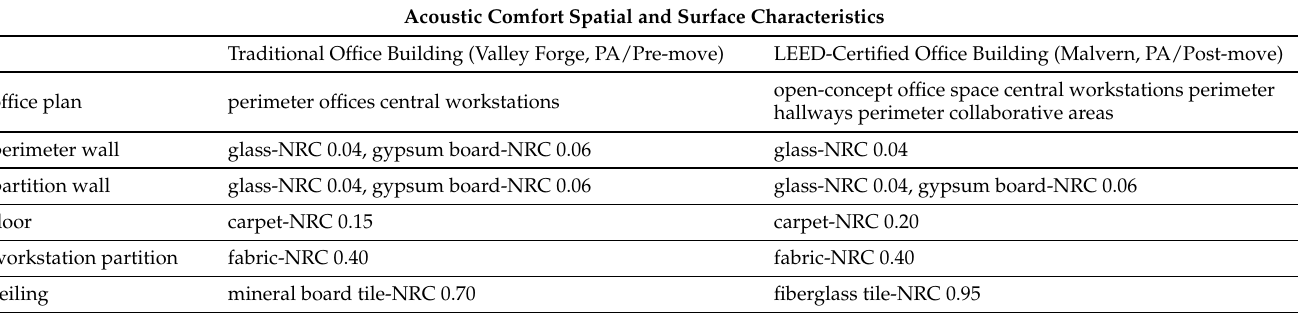
Table 1. Comparison of acoustic comfort spatial and surface characteristics between office